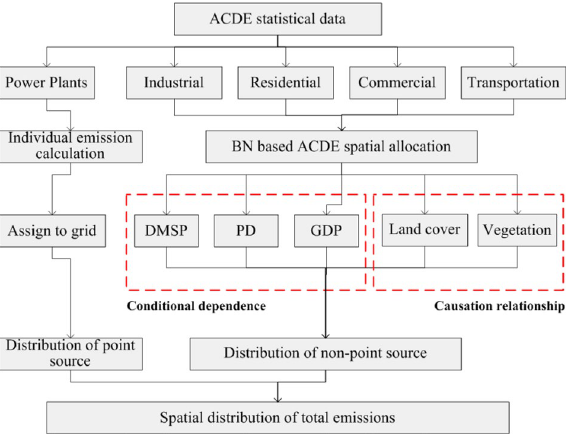
Figure 9. Flow chart of spatial allocation of ACDE statistical